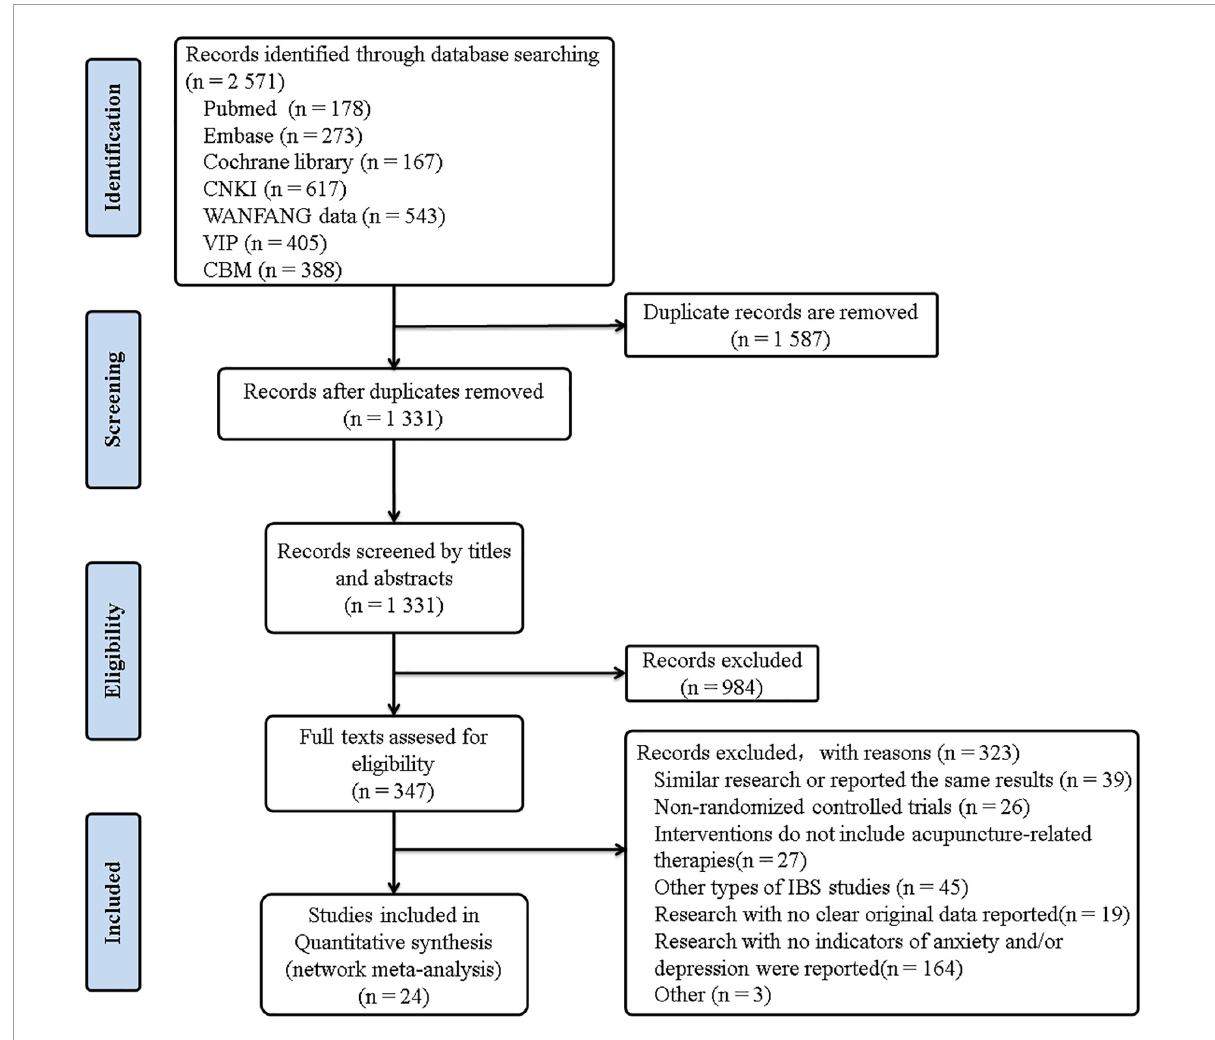
FIGURE1 Study flow